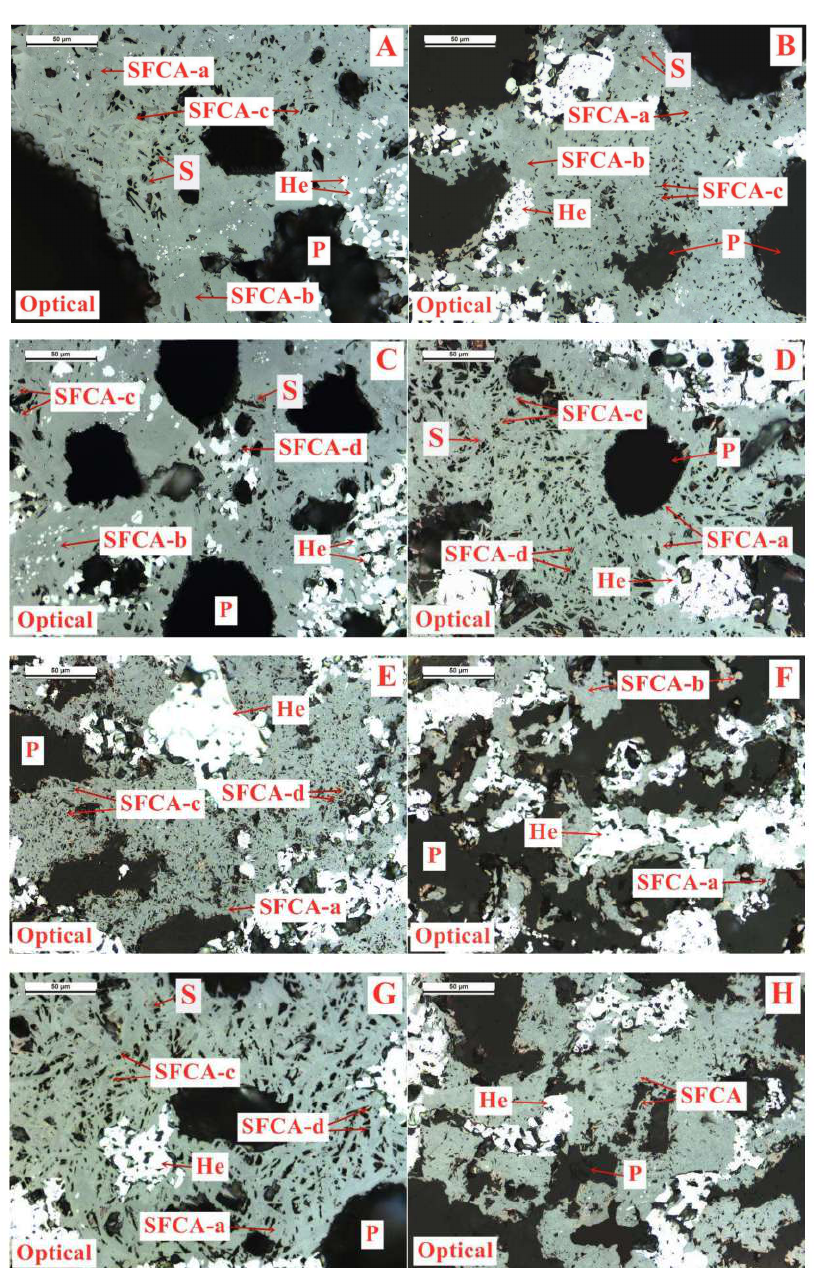
Figure 7. Characteristics of the bonding matrix in sinter tablets of various types of iron ores (( A – H ) represent the optical photographs of iron ores A-H respectively; He: Hematite; S: Silicate; SFCA-a-Tabular: SFCA; SFCA-b-Lamellar: SFCA; SFCA-c-Dendritic: SFCA; SFCA-d-Acicular: SFCA; P: